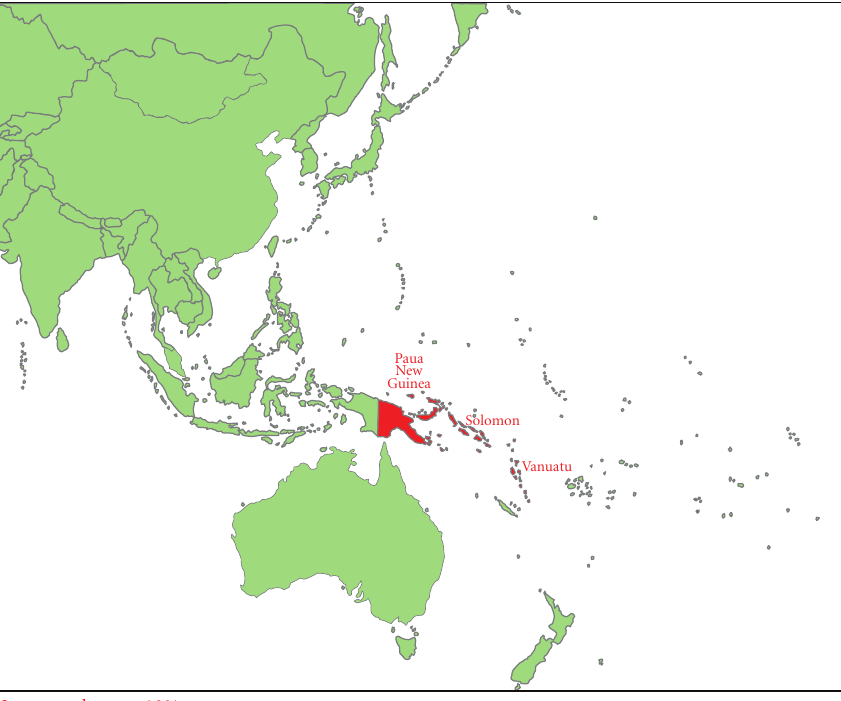
Figure 2: Yaws prevalence in the Western Pacific Region in the 1960s.